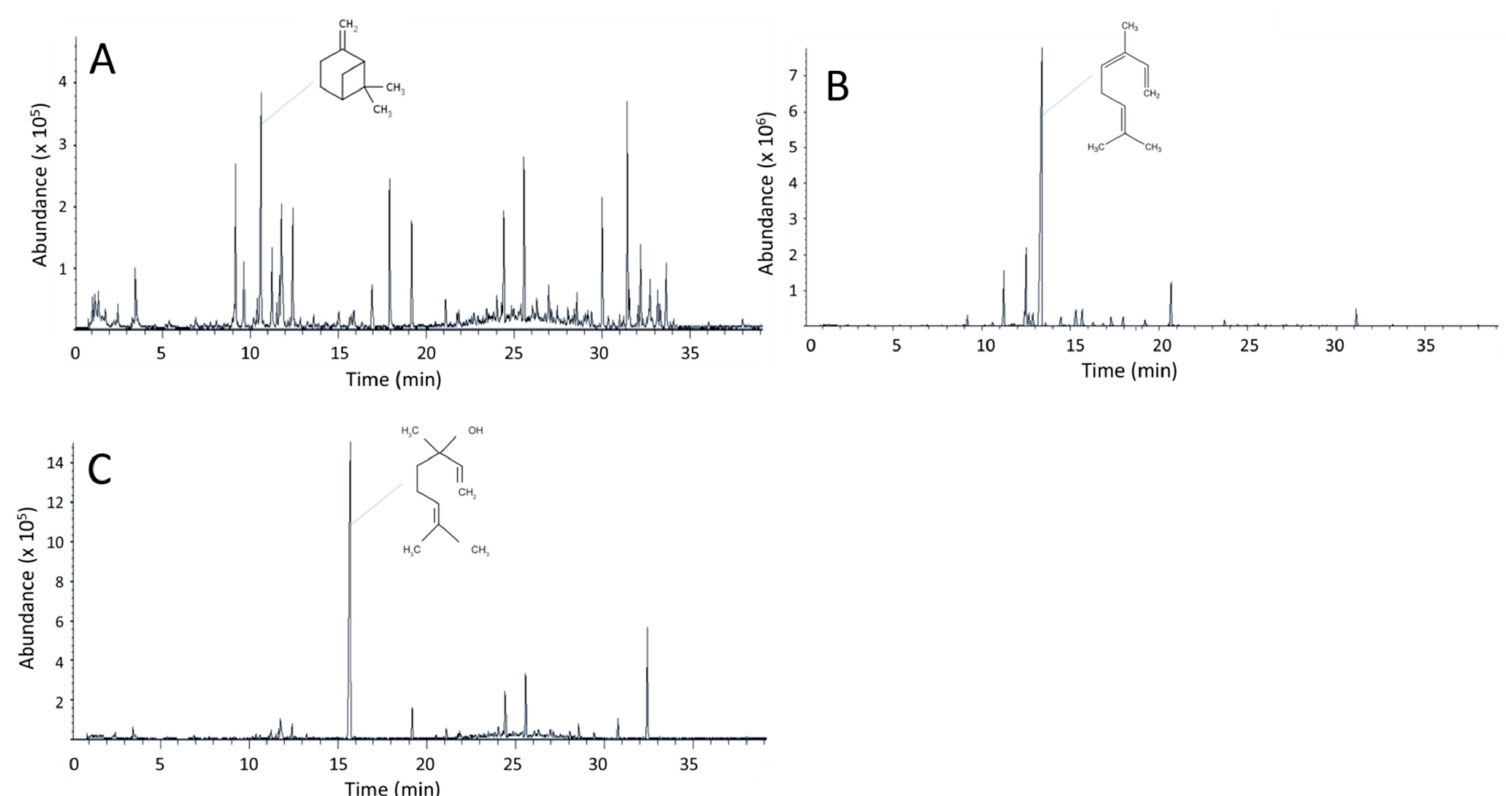
Figure 3. Chromatograms obtained from the analysis through GC-MS to detect the floral scent of ( A ) chrysanthemum, ( B ) oriental lily, and ( C ) freesia, showing the highest peak in each case ( β -pinene, β -cis-ocimene, and linalool, respectively).